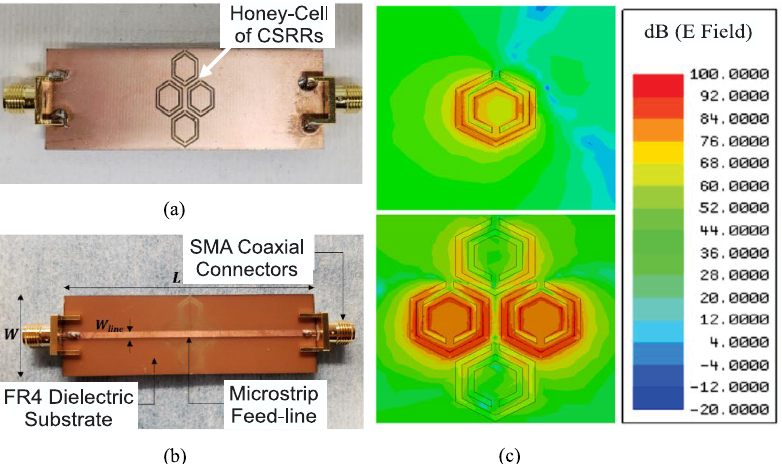
Figure 10. Honey-cell CSRR sensor consisting of four coupled hexagonal-shaped CSRRs ( a ) coupled to a microstrip line ( b ). Electric field distribution on the CSRR surface at a 3.0 GHz resonant frequency when a honey-cell and a single hexagonal-shaped CSRR are used. ( c ) Electric field concentration at the frequency of resonance for both single (top) and coupled CSRRs (bottom). Reprinted with permission from Ref. [34].